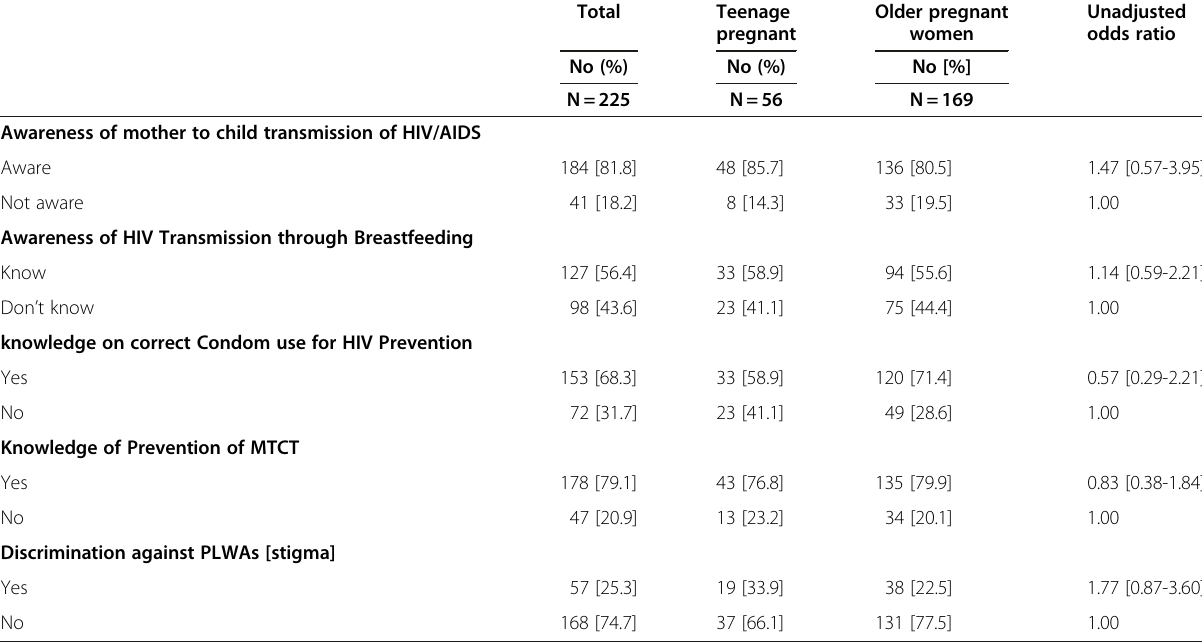
Table 2 Knowledge of transmission and prevention of MCTC by respondents